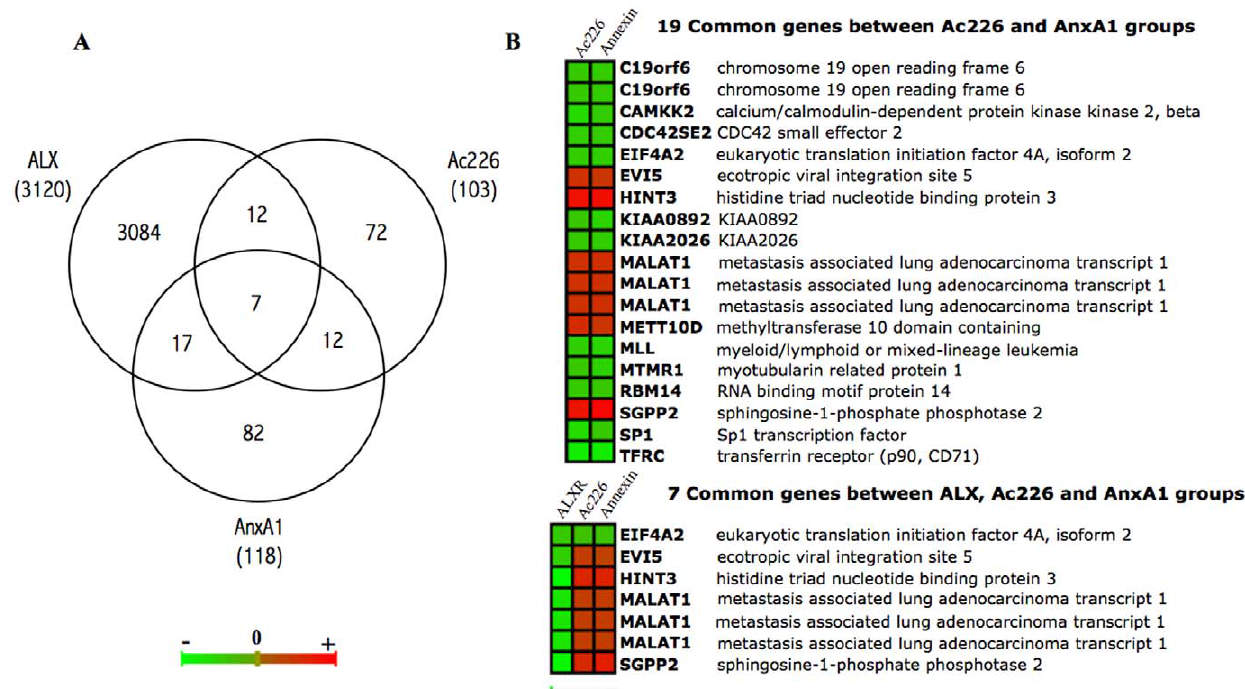
Figure 3. Common differentially expressed probes among ALX, AxnA1 and Ac2-26 groups. A) Venn diagram comparing the differentially expressed probes identified in each group (ALX, Ac226 and AnxA1). B) Expression of the 7 probes differentially expressed in all groups and the 19 probes differentially altered by the two peptides (Ac226 and AnxA1), obtained from the Venn diagram. Up-regulated probes are displayed in red and down-regulated in green.